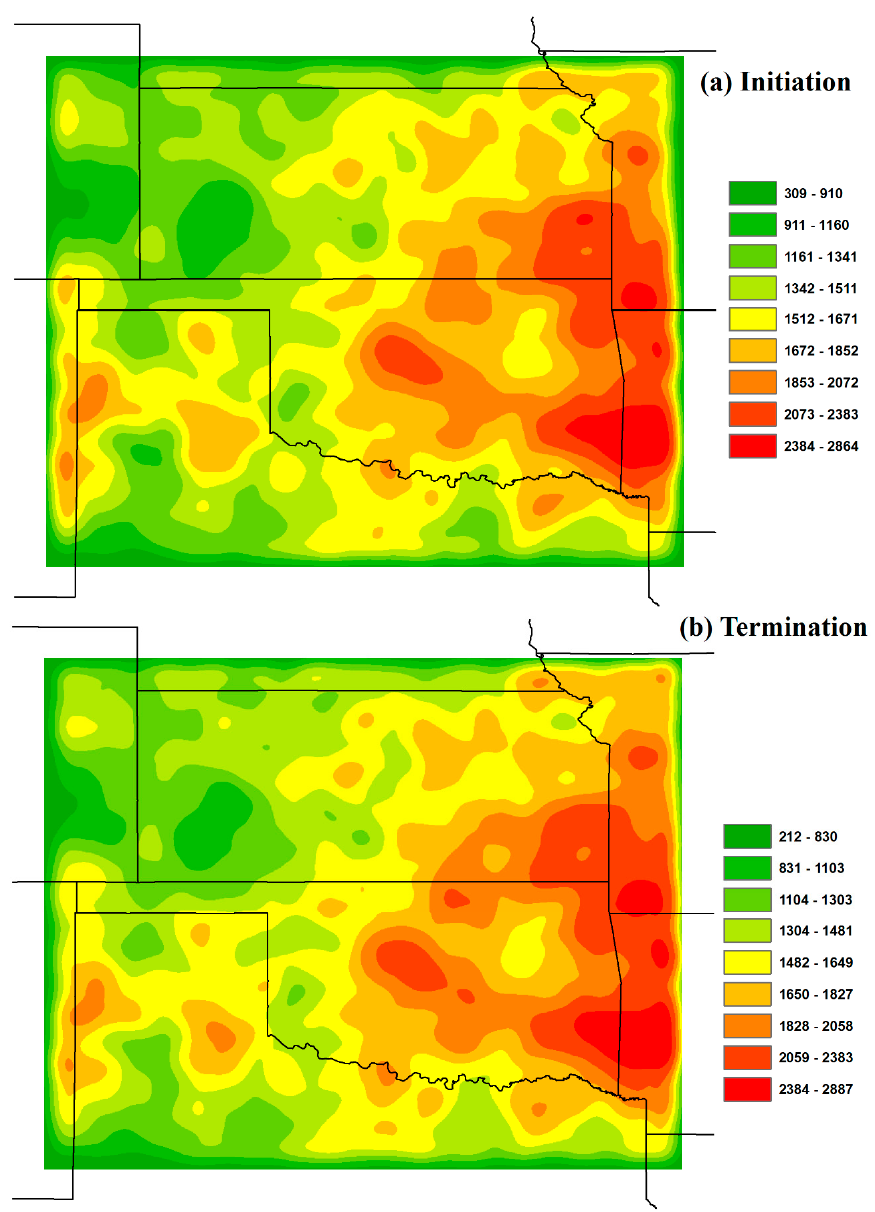
Figure 10. Thunderstorm initiation ( a ) and termination ( b ) density (count/km 2 ) maps.